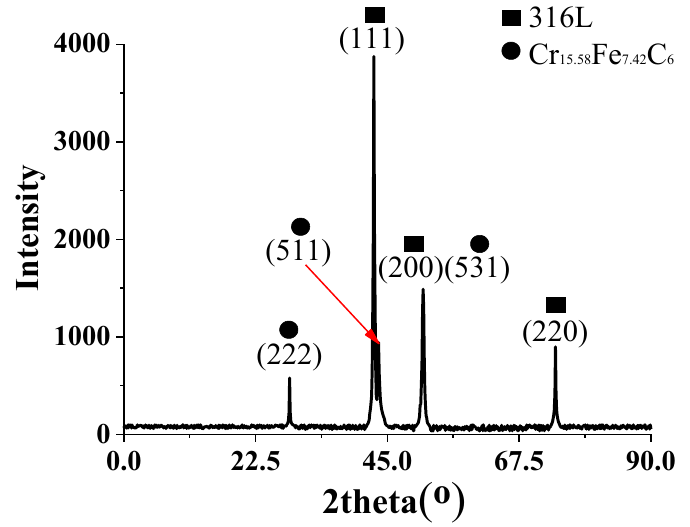
Figure 9. Diffraction analysis of the stainless-steel side of the 55#/316L rebar.